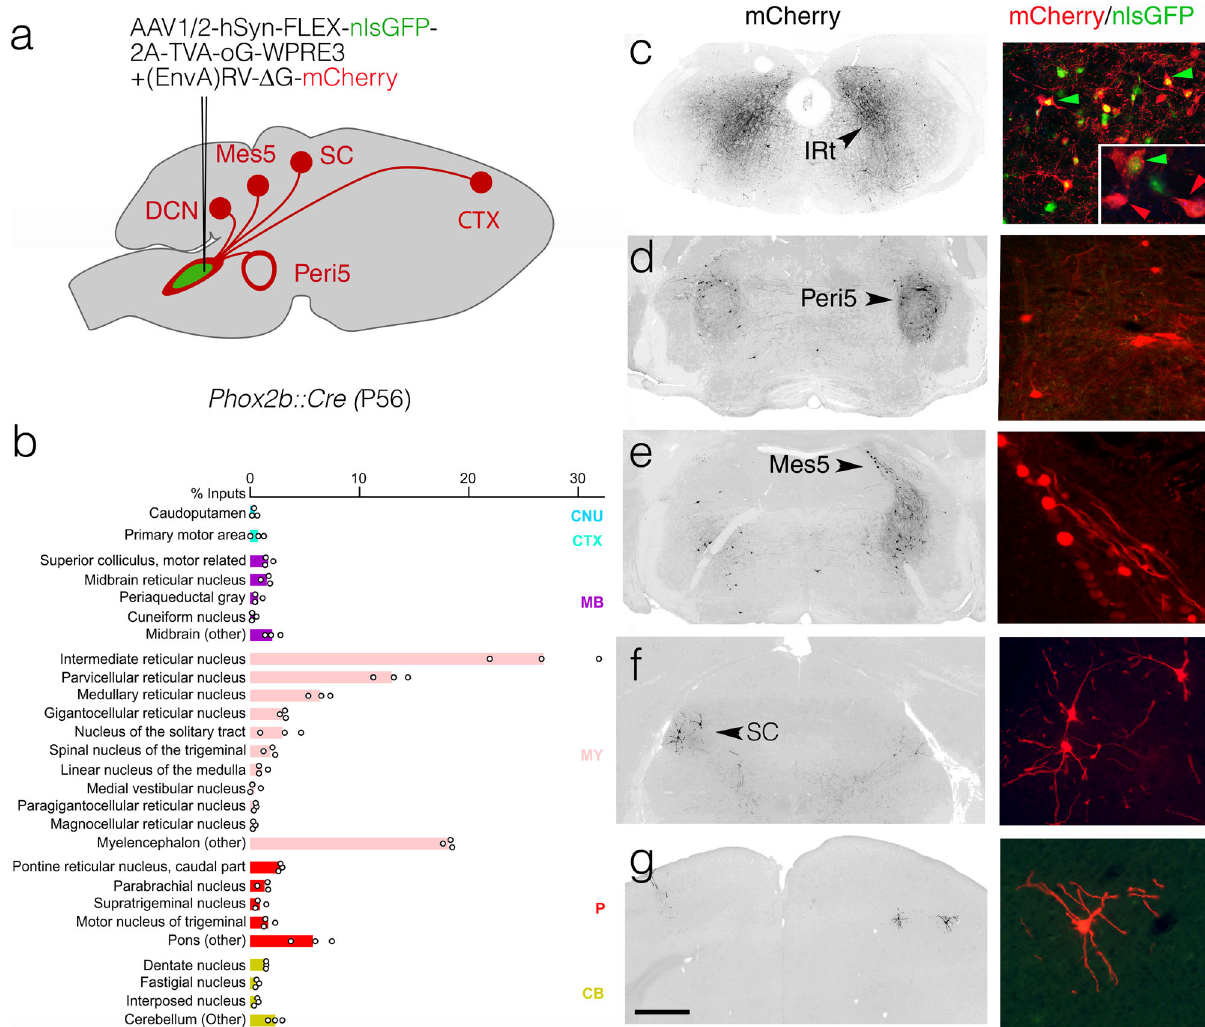
relative percentage of monosynaptic input neurons labeled from IRt Phox2b starter neurons, displayed per brain region as de fi ned in the Allen Brain